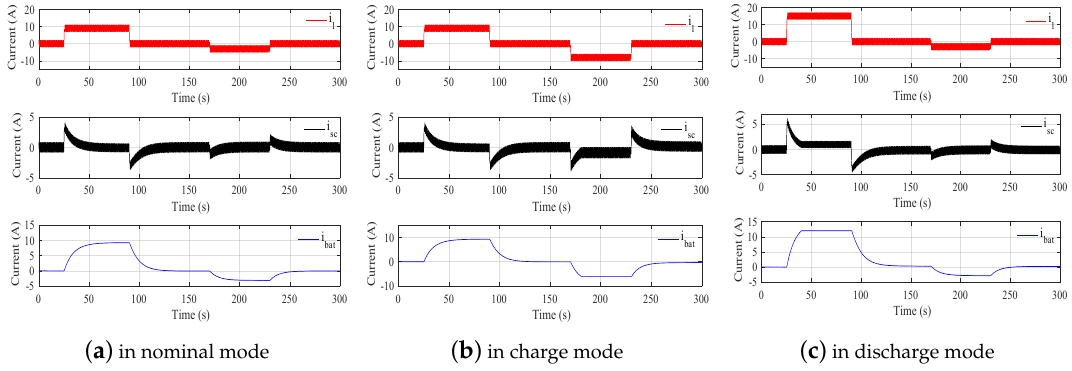
Figure 8. Simulation results of the battery, supercapacitors’, and load currents with